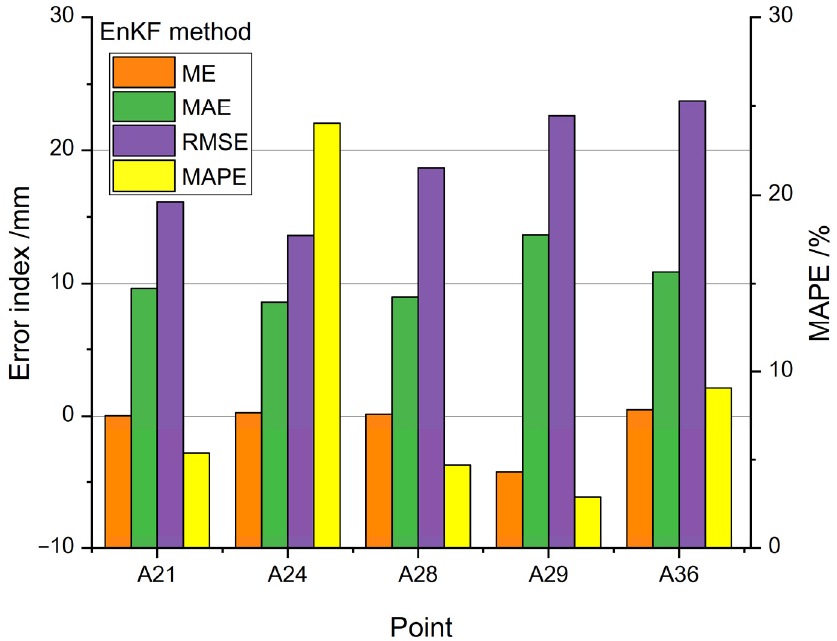
Figure 13. Error indexes of the typical points using EnKF method.